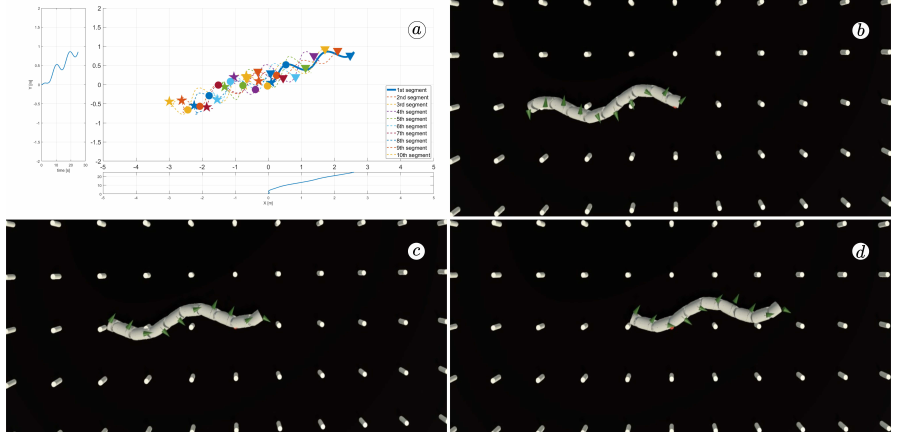
Figure 29. Trajectories of robot segments for φ i ,ref = 50 ◦ sin ( 50 ◦ t + ( i − 1 ) 60 ◦ ) ( a ) and robot configu- rations for t = 5 ( s ) ( b ), t = 10 ( s ) ( c ), and t = 24 ( s ) ( d ).